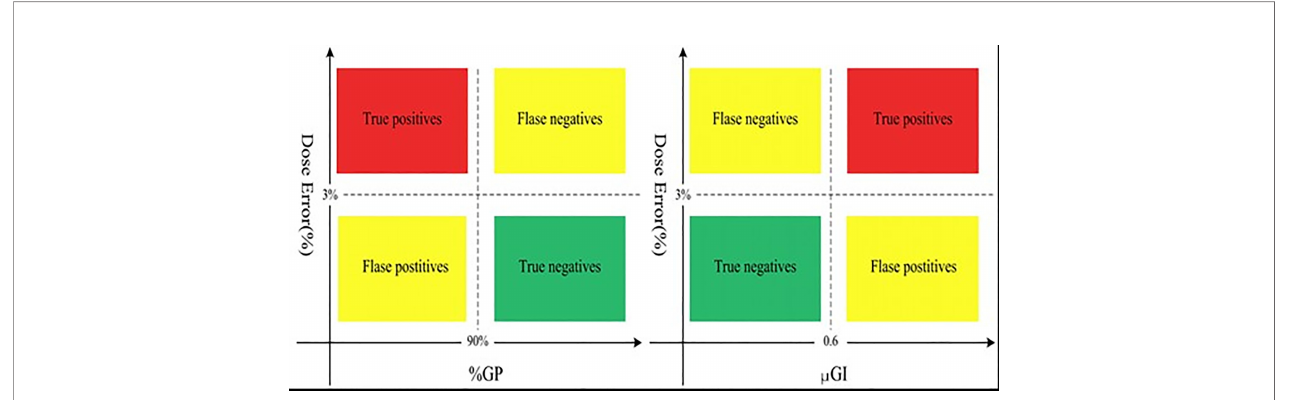
FIGURE 5 | The DVH_%GP and DVH_ m GI evaluation